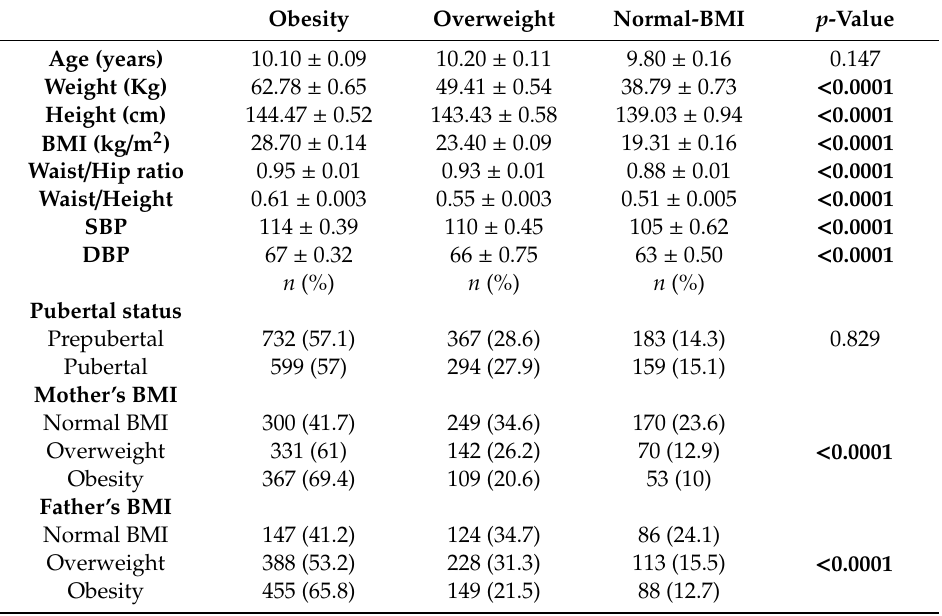
Table 1. Clinical characteristics of all subjects at initial assessment.